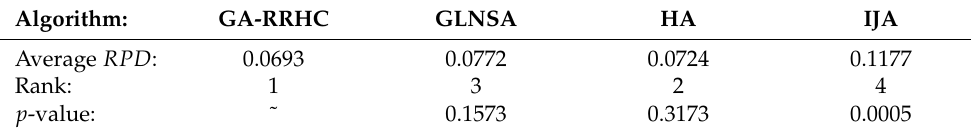
Table 10. Algorithm ranking and Friedman test value for Vdata dataset.